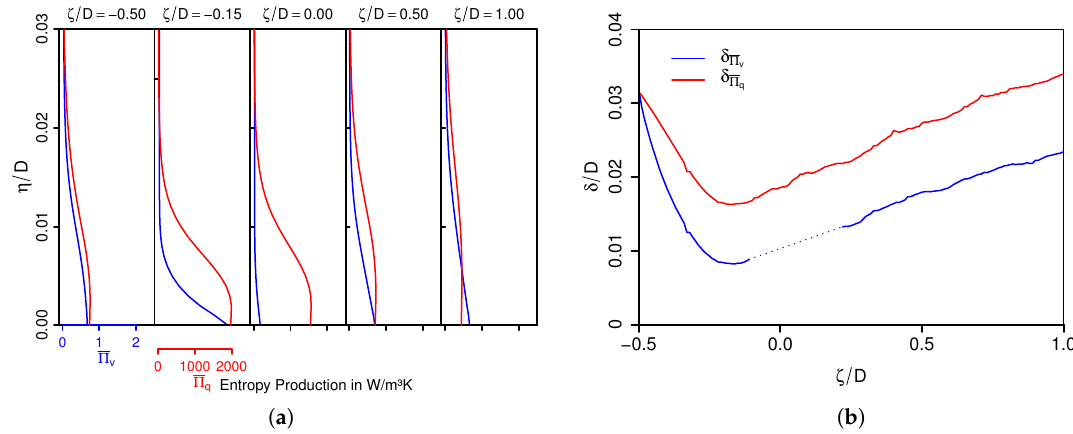
Figure 11. ( a ) Profiles of time-averaged entropy production rates due to viscous dissipation Π v and to heat conduction Π q as a function of non-dimensional wall distance η / D ; ( b ) boundary layer thickness of Π v and Π q